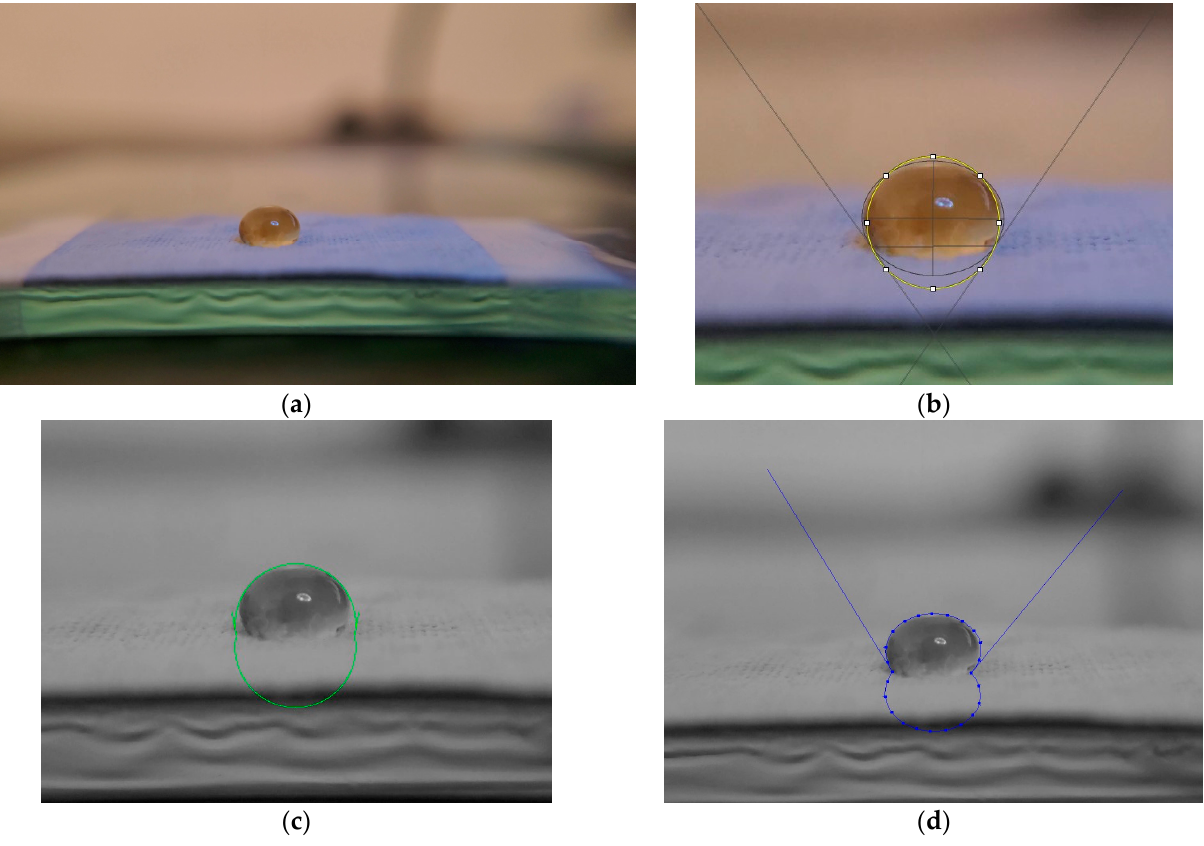
Figure 1. ( a ) Oil droplet on filter; ( b ) Droplet observed using ImageJ Contact Angle Plugin; ( c ) ImageJ Drop Shape Analysis Plugin (LB ‐ ADSA); ( d ) ImageJ Drop Shape Analysis Plugin (DropSnake).